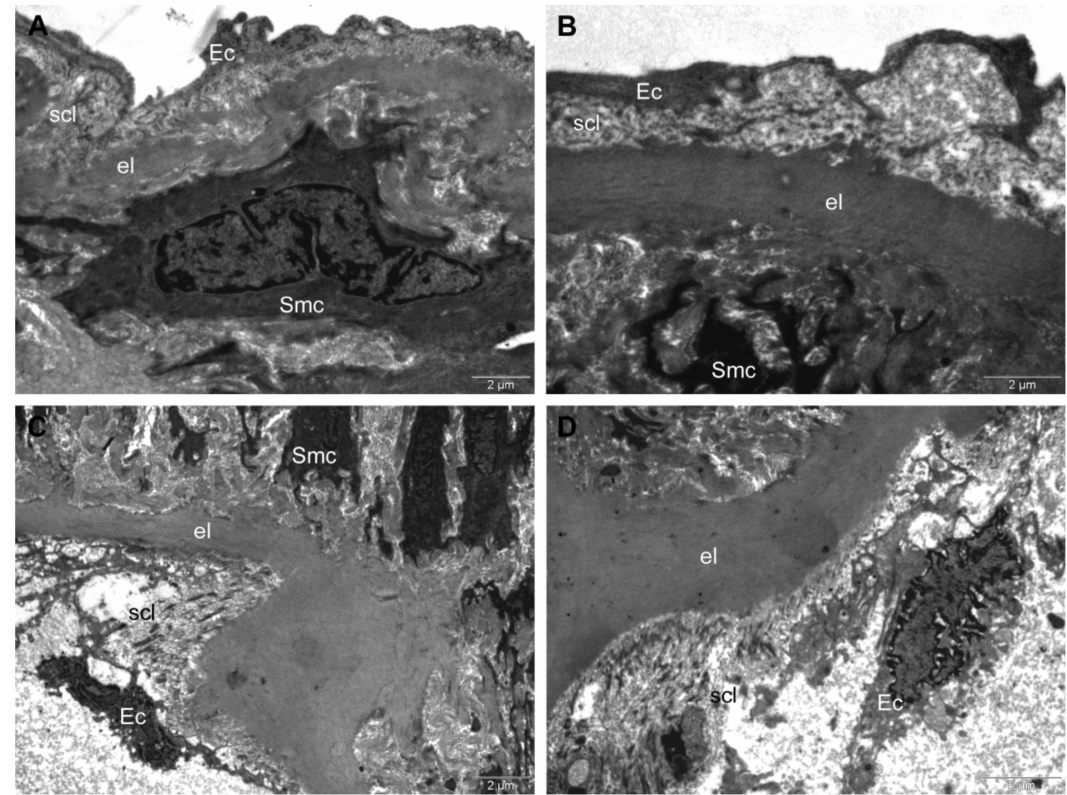
Figure 8. TEM investigation of descending aorta of rats with HFD for 9 months; the last month with oral gavage treatment ( Cornus mas L. extract for HFD + CM group and gold nanoparticles functionalized with bioactive compounds from Cornus mas L. extract for HFD + AuNPsCM group) showed normal intima aspect, but thinned subendothelial connective layer in HFD + CM group ( A , B ). In HFD + AuNPsCM group, TEM investigation showed: deeply altered endothelial cells that were weakly connected to the elastic lamina; extensive denudation of inner elastic lamina; disorganized subendothelial connective layer with lipid inclusions and almost completely disrupted collagen network ( C , D ). (Ec, endothelial cell; el, elastic lamina; scl, subendothelial connective layer; Smc, smooth muscle cell; l, lipid